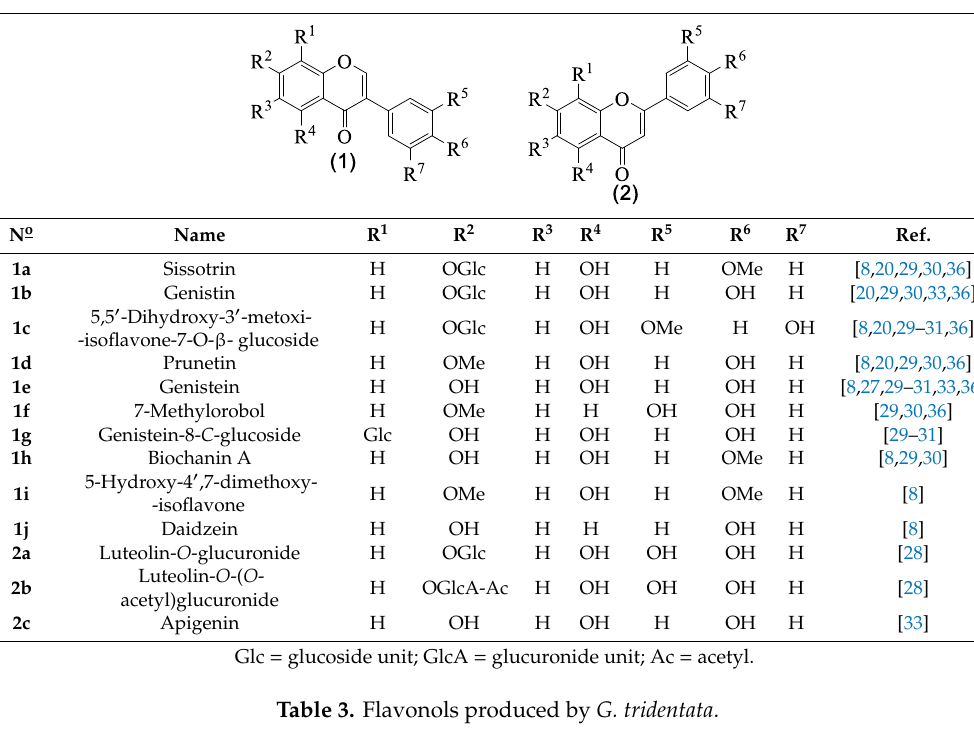
Table 3. Flavonols produced by G. tridentata .